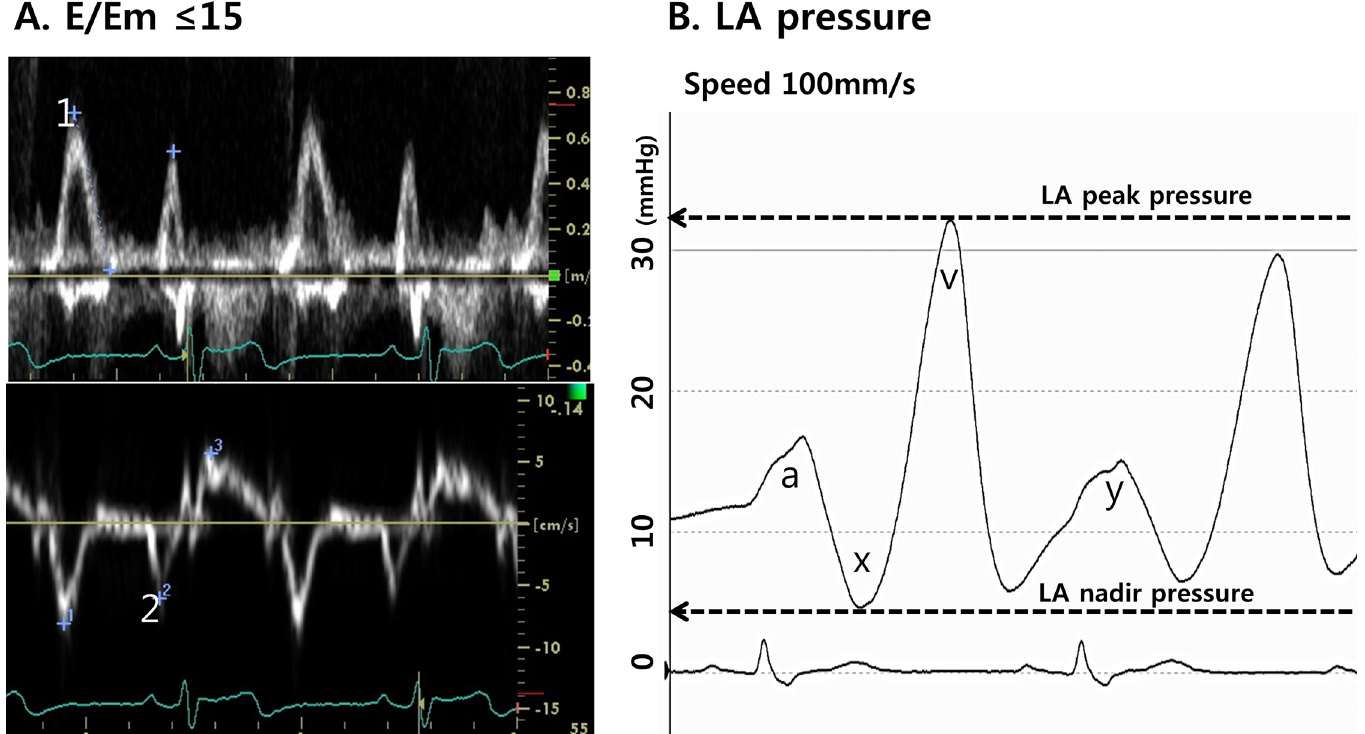
Fig 1. (A) Tissue Doppler images of the mitral annular septal area (peak diastolic velocity [Em]) and the flow velocity of mitral inflow were acquired. Patients with E/Em > 15, suggesting left ventricular (LV) diastolic dysfunction, were excluded. (B) LAP peak (v wave), LAP nadir (x wave), and LAP mean were measured during sinus rhythm, and LA pulse pressure (LApp) was calculated by subtracting LAP nadir from LAP peak (the difference between LAP peak and LAP nadir